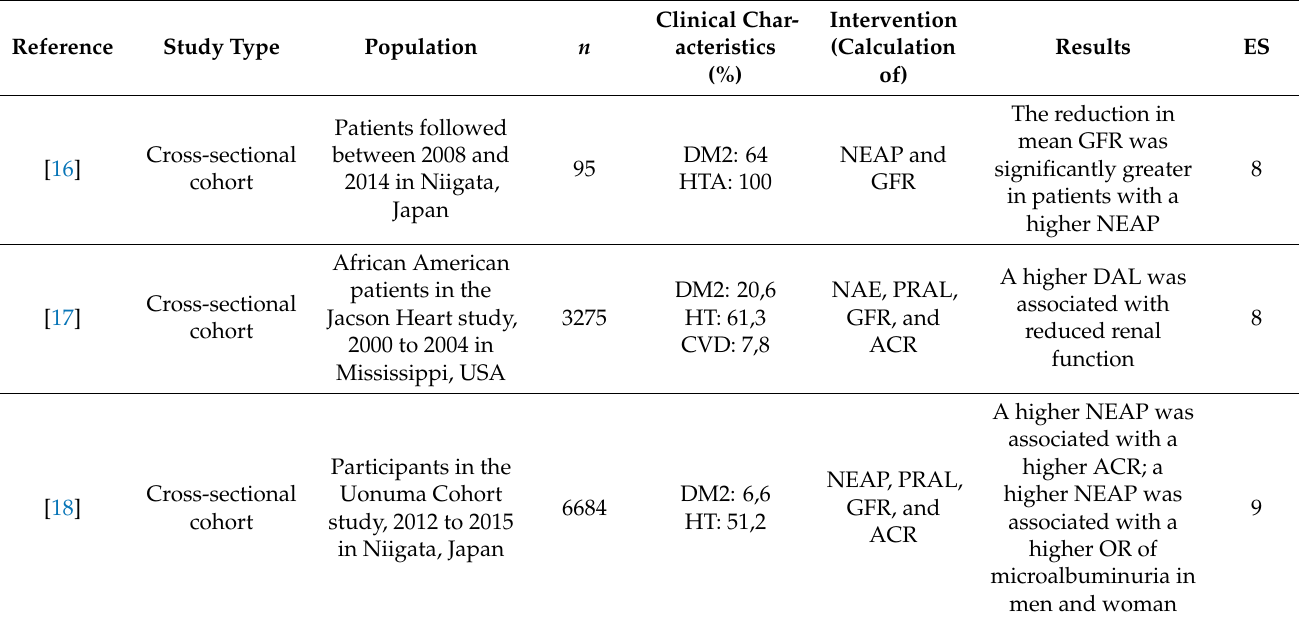
Figure 1. Diagram for the selection of articles. Table 1. Analyzed studies.